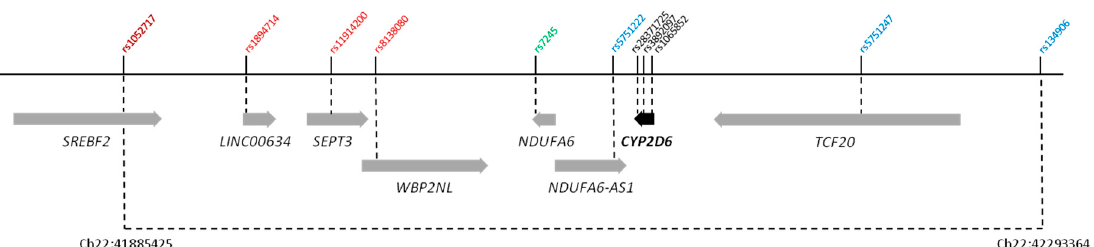
Figure 1. Long-range polymorphisms on chromosome 22, including single-nucleotide polymorphisms (SNPs) located upstream and downstream of the CYP2D6 gene. Variants selected for verification from blocks 1, 2, and 3 of associated SNPs are indicated in red, green, and blue, respectively.